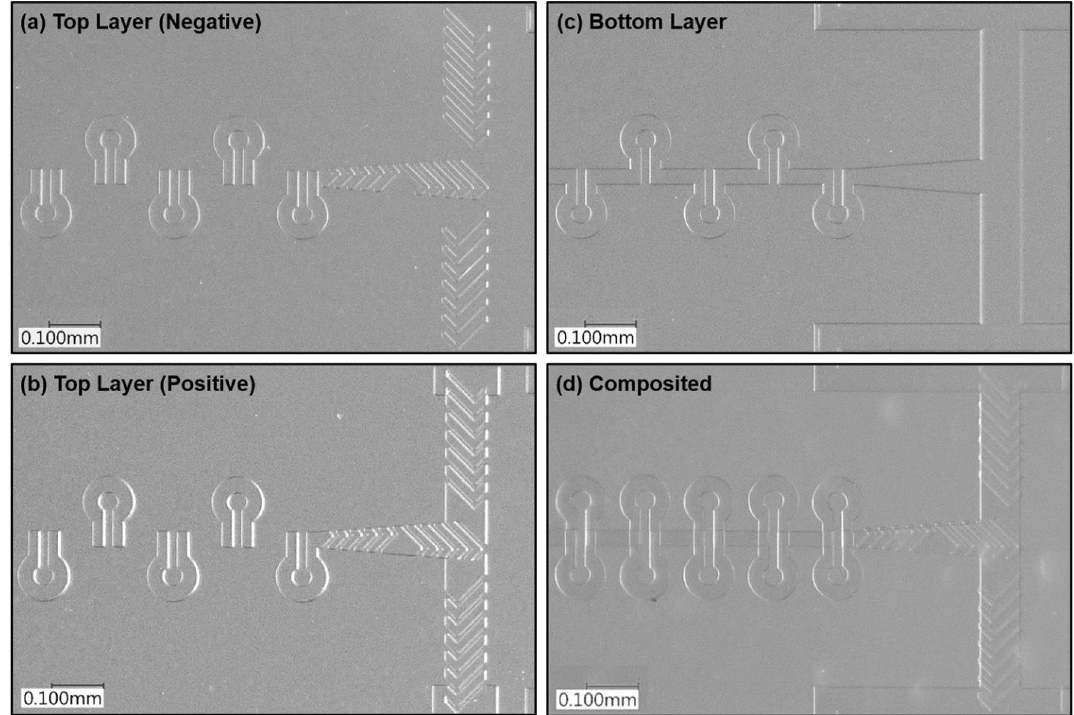
Figure 2. White light microscopy images of SU-8 mold of pattern C top layer with negative grooves (a) , PDMS replicas of pattern C positive grooves of top (b) and bottom (c) layers. (d) is an example of the composite micromixer fabricated by plasma bonding PDMS replicas (a) and (c) . All images were taken with a × 20 microscope